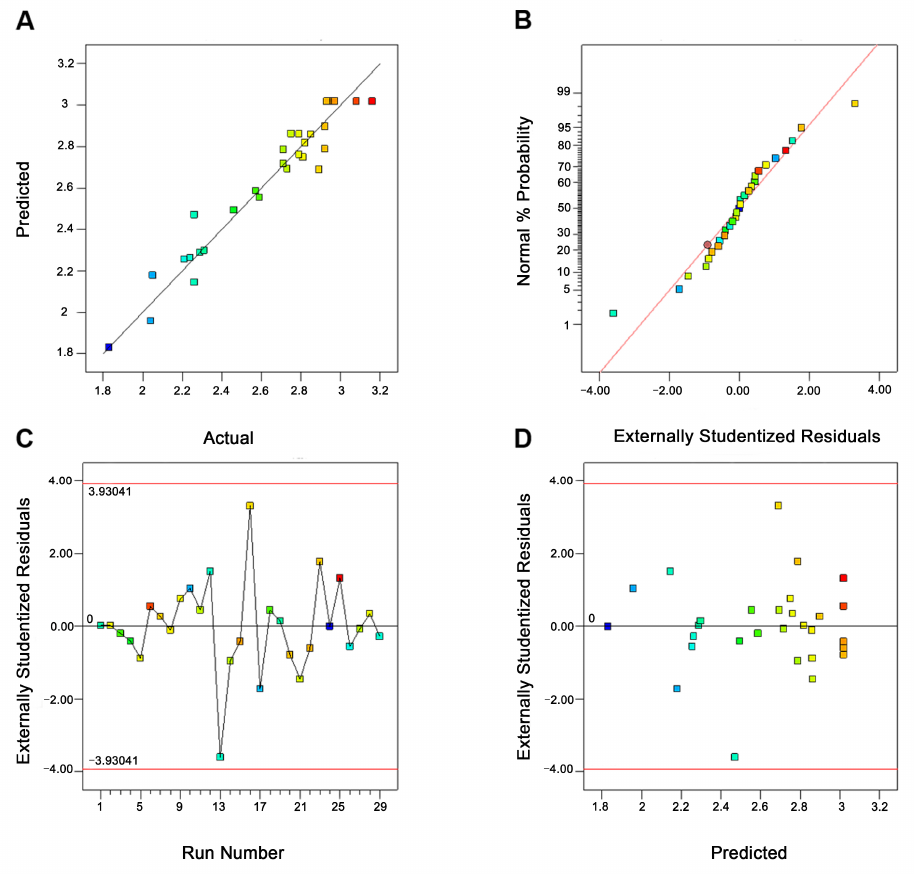
Figure 2. Diagnostic plots for the response surface model adequacy. ( A ) Plot of predicted versus the actual values. ( B ) The normal percent Probability plot. ( C ) Plot of internally studentized residuals versus the formula predicted. ( D ) Plot of internally studentized residuals versus the experimental run.